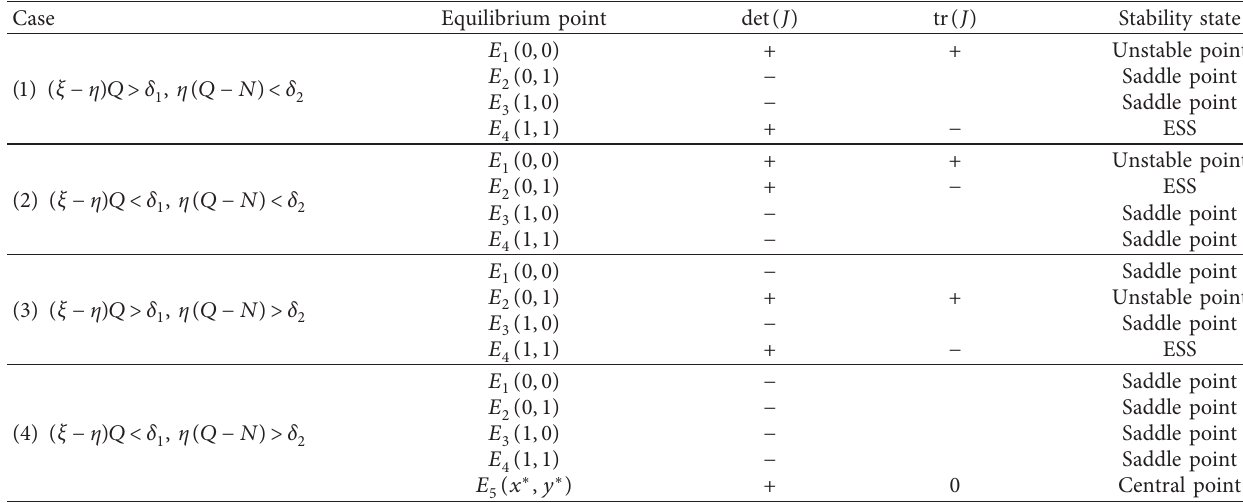
Table 3: The local stability of each equilibrium point under four